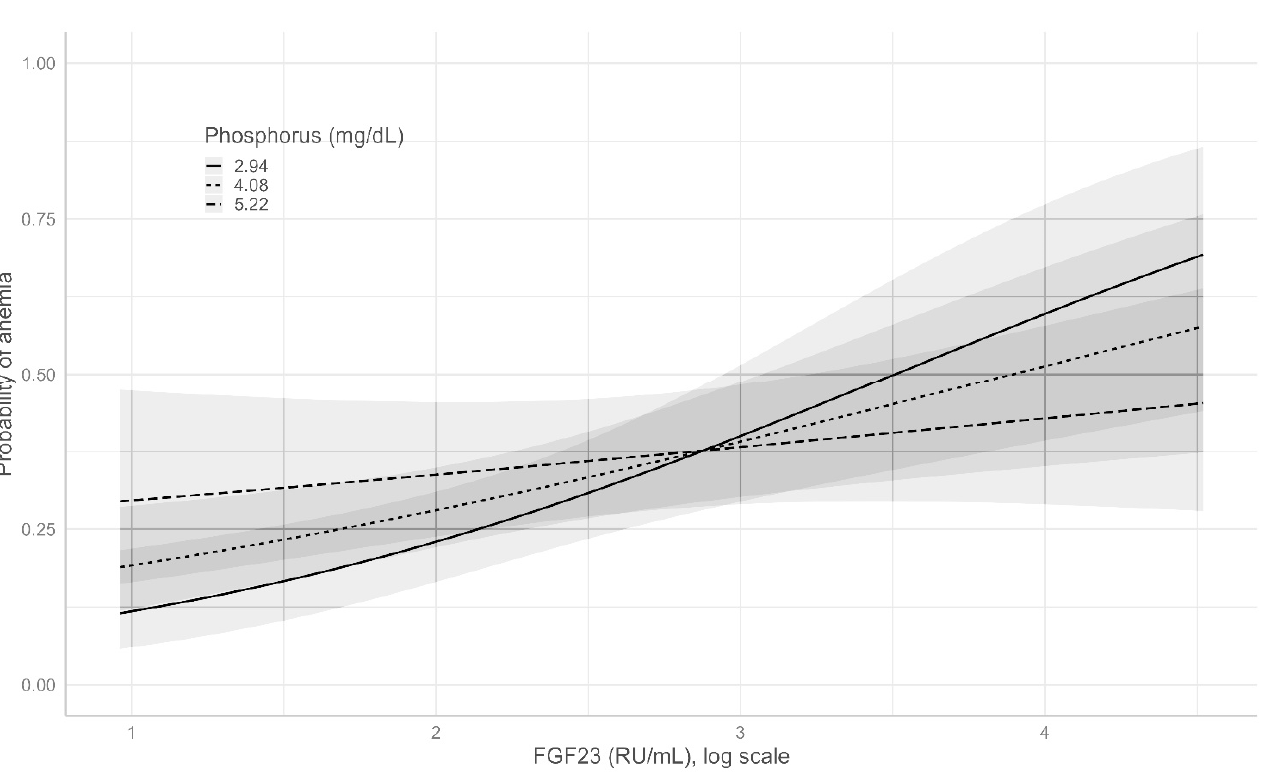
Figure 3. Adjusted predicted probability (95% CI) of anemia with different values of iGF23 and serum phosphate.